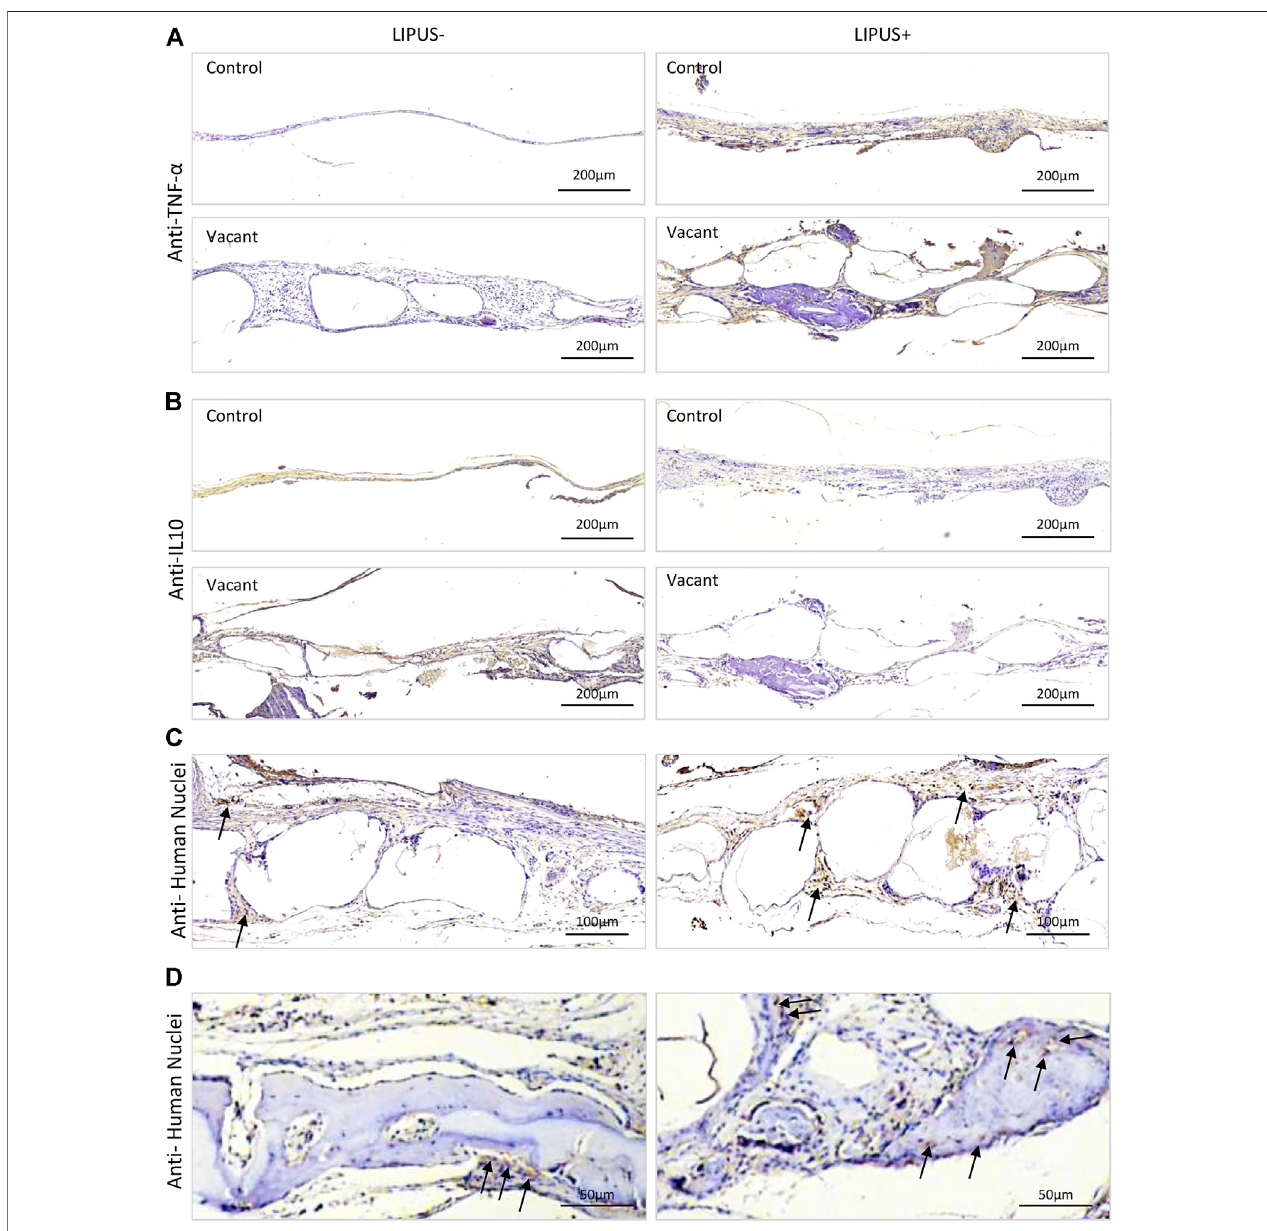
FIGURE4| RepresentativeIHCstainingimagesafter12 weeksofLIPUSstimulation invivo . (A) IHCstainingforTNF- α . (B) IHCstainingforIL10. (C,D) IHCstaining for human nuclei. Black arrows represent positively stained human cells.